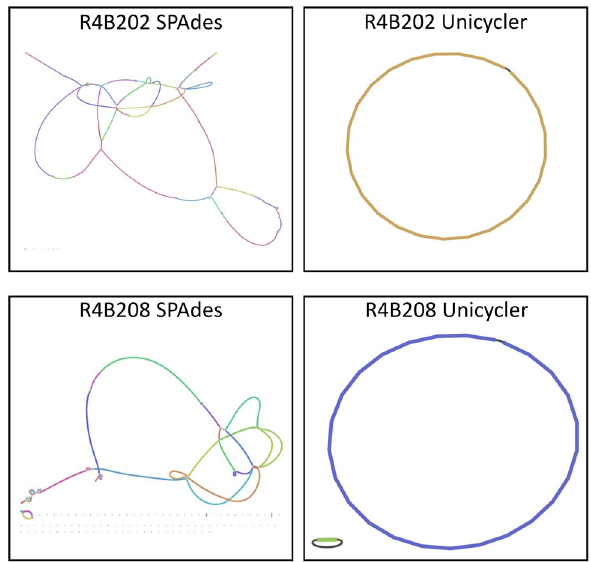
Figure 2. C. jejuni Field Isolate Assembly Graphs. The SPAdes and Unicycler genome assembly graphs for C. jejuni field isolates R4B202 and R4B208 were visualized using Bandage. The colors denote different nodes, and the black connecting lines represent known overlaps. Branching node intersections are caused by multiple potential overlapping